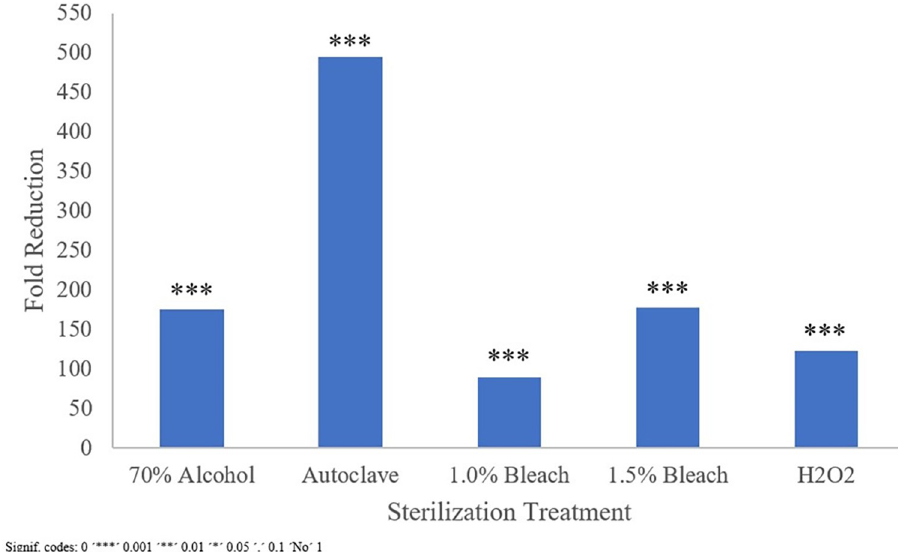
Fig 4. DESeq2 differential abundance of OTU003 ( Erwinia ) in treated pulse flours following simulated in vitro colonic fermentation for 24 h at 37˚C with feces added. All pulse flour types are grouped together by their treatment and comparisons are made against the unsterilized control The p -values from DESeq2 were corrected for multiple comparison with the false discovery rate method, � indicating corrected p < 0.05, �� corrected p < 0.01, ��� corrected p <